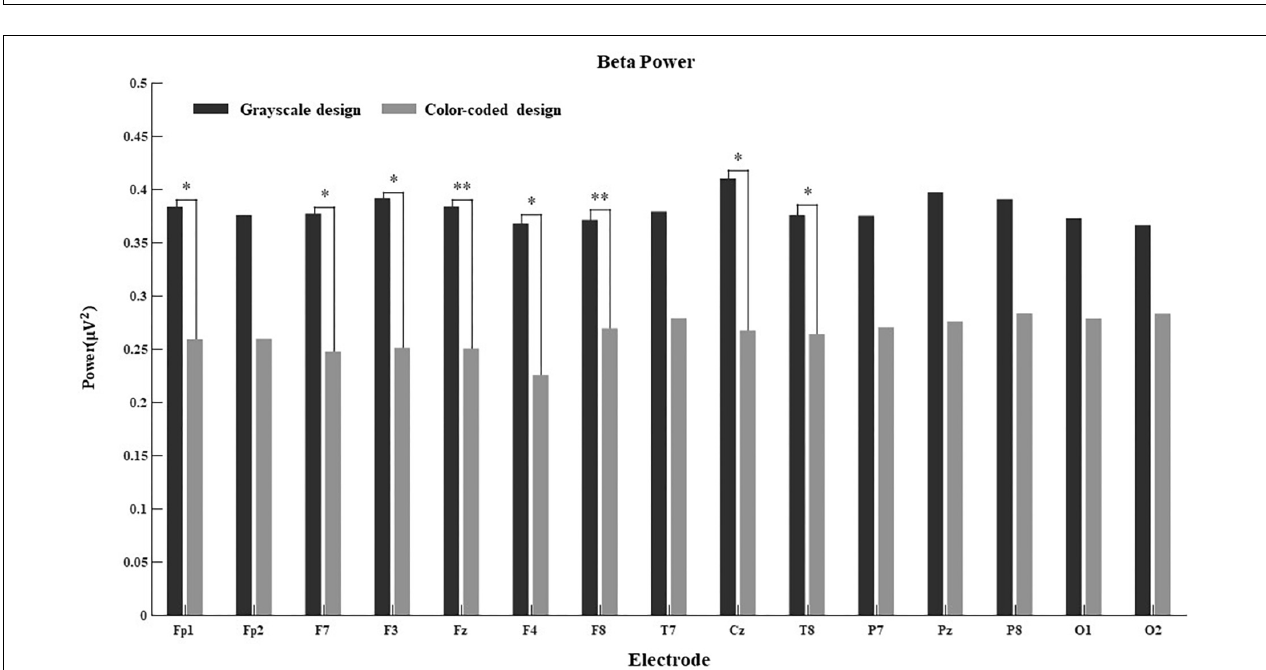
FIGURE 7 | Beta power for the 15 electrodes in the grayscale and color-coded conditions while watching video lectures ( ∗ p < 0.05, ∗∗ p < 0.01).